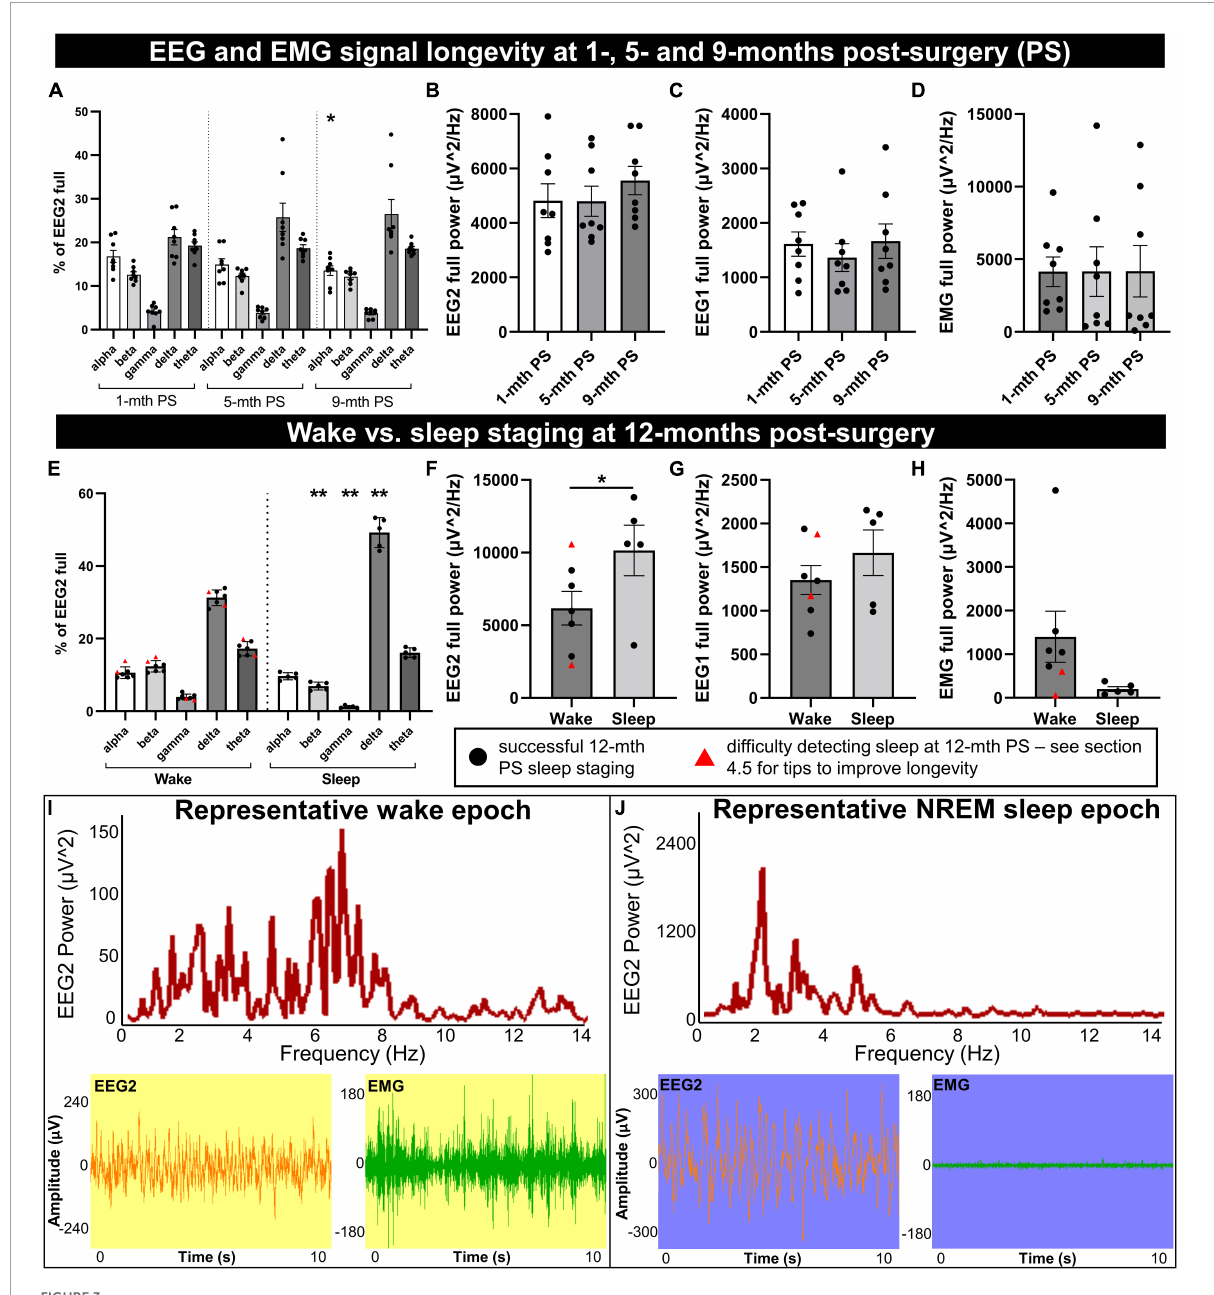
FIGURE3 Longevity of EEG signal integrity until 9 to 12 months post-implantation. Mice were implanted with EEG/EMG headcaps, and recordings were collected at 1, 5, and 9 months post-surgery (PS) to look at signal longevity ( n = 8), and sleep was staged at 12 months post-surgery (PS) ( n = 7). Power was generated in alpha (8–13 Hz), beta (13–30 Hz), delta (0.5–4 Hz), theta (5.5–8.5 Hz), and gamma (35–44 Hz) bands for the anterior EEG electrode (EEG2), as well as full range (0.5–500 Hz) for EEG2, EEG1 (posterior) and EMG. (A) No overall effects of post-surgical time were detected on the proportion of neuronal frequency bands; differences between bands were significant on ANOVA. One significant post hoc comparison was detected between alpha banded power at 9 vs. 1-month post-surgery ( P = 0.014). The full power of EEG2 (B) , EEG1 (C) , and EMG (D) channels did not significantly change between 1, 5, and 9 months post-surgery. At 12 months post-surgery, power was split by vigilance state for wake vs. sleep. (E) During sleep, there were proportionally fewer beta and gamma waves, and more delta than wake. Full EEG2 power was significantly increased (F) , EEG1 trended ( P = 0.055) to increase (G) , and EMG trended ( P = 0.097) to decrease (H) , in sleep compared to wake. Sleep was difficult to detect in two mice by cluster or manual staging (marked by red triangles), likely due to consistently low EMG. (I,J) Representative frequency distribution of wake and NREM sleep in 10 s epochs, with the corresponding EEG and EMG traces, demonstrate low amplitude/mixed frequency and high amplitude delta waves, respectively. Supplementary Figure 4 documents raw traces for REM, NREM, and wake and epoch frequency distribution for REM. Data are mean ± SEM. Two-way (A) and one-way (B–D) repeated measures ANOVA, multiple comparisons controlled for with Tukey post hoc test; multiple paired t -test with multiple comparisons controlled for with Holm–Šídák method (E) , paired t -test (F–H) . * P < 0.05, ** P <